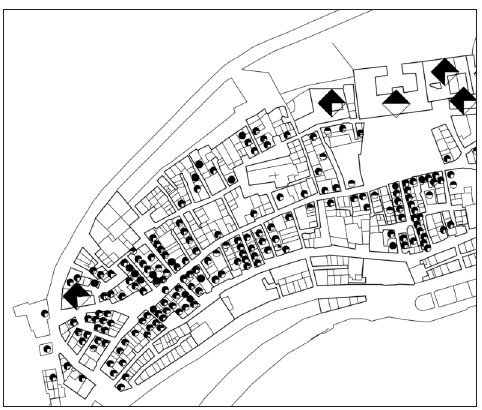
Fig. 8. 1857 ‘scenario’ for Potenza: detail of dam- age in Portasalza-Portamendola quarters, where many buildings collapsed.